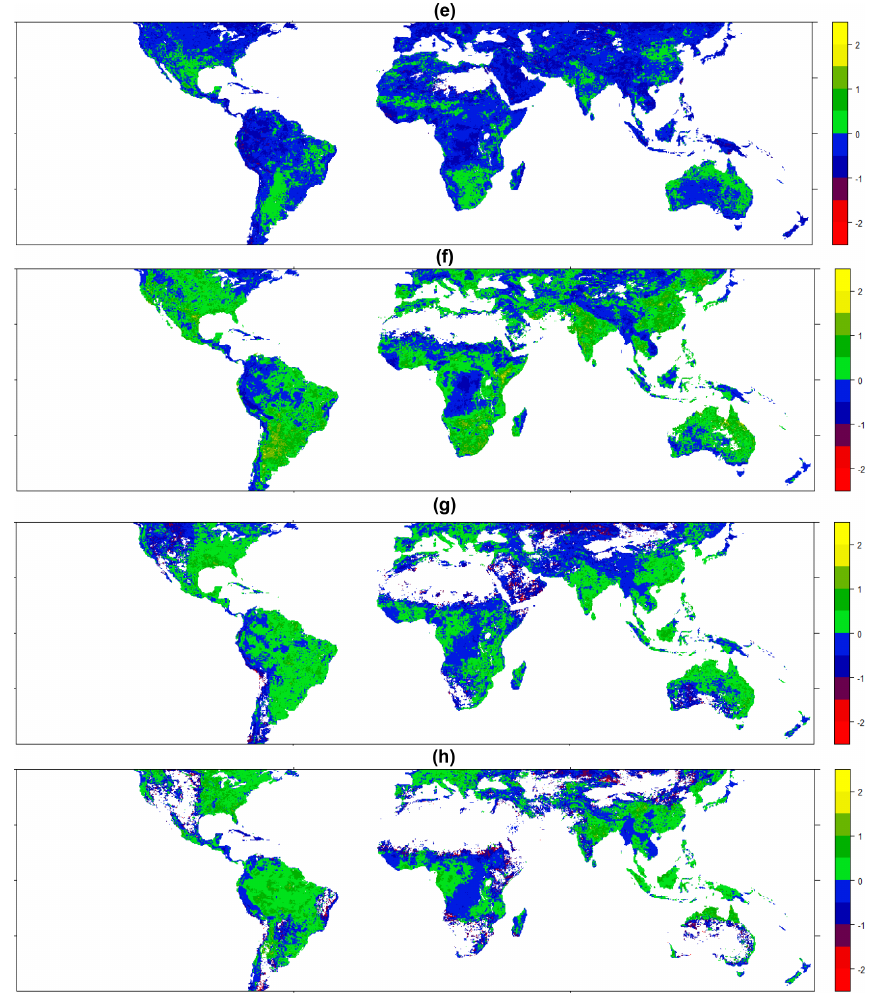
Figure 6. Values of log 10 (β X,j ) , where β X,j is the scaled model uncertainty in variable X (Eq. 2) (log 10 (β X,j ) < 0 indicates model uncertainty in the predicted variable X is less than the variability in the input precipitation forcing data; > 0 indicates model uncertainty in the predicted variable X is greater), where X is evapotranspiration (a, c, e, f) or runoff (b, d, g, h) and j refers to either high extremes (a, b, e, g) or low extremes (c, d, f, h) . Points on the scatter plots are coloured according to latitudinal zones (Fig. 1). Because of the density of overlapping points, only the envelope of points for each latitudinal zone is shown and the points with the highest uncertainty (uncertainty DIU ≥ ( 2 / 3 ) · (global maximum of DIU)). Linear regression lines for each latitudinal zone indicate the trend as precipitation increases within each zone (all regressions were significant at the 1% level), although, n.b., we do not contend in any way that the distribution of points shown is linear: these lines simply indicate a trend that is not clear to the eye from the envelopes displayed (which do not show the complete point cloud). Maps (e–h) show the corresponding spatial distributions of log 10 (β X,j ) values for each variable, with the colour scales corresponding to the vertical axis on scatter plot (a)